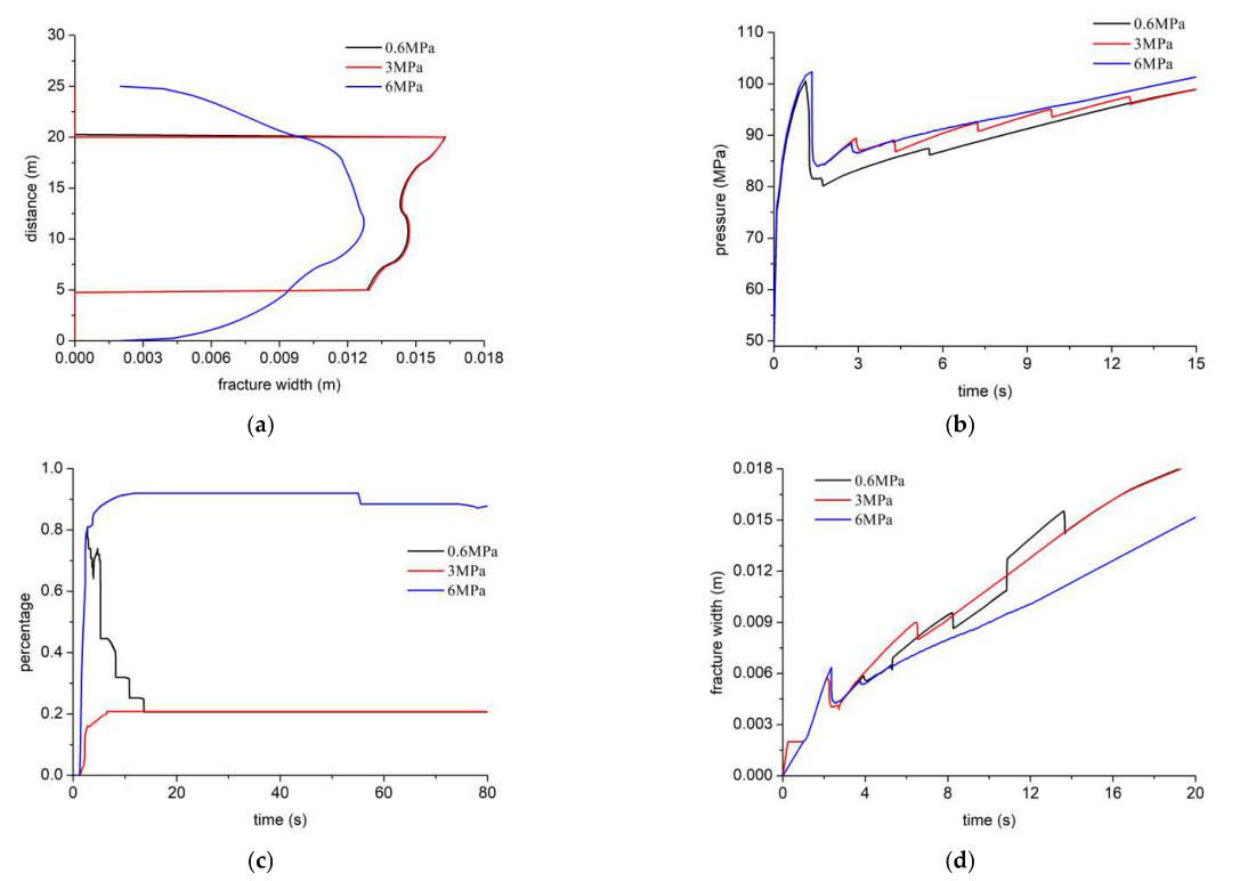
Figure 13. Fracture parameter under different bond strengths: ( a ) HF width; ( b ) pressure; ( c ) ratio of tensile failure; and ( d ) maximum HF